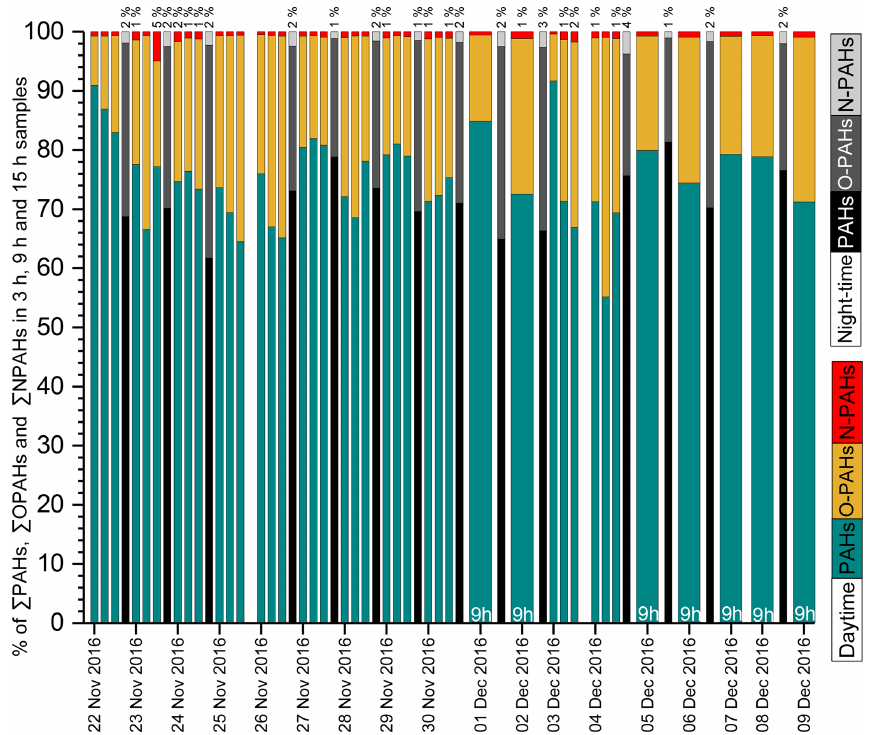
Figure 2. Time series of P PAHs, P OPAHs and P NPAHs in PM 2 . 5 samples during the daytime (3 and 9h) and night-time (15h). Percent- ages below 1% for NPAHs are omitted for clarity. Night-time data on 25 November 2016, 3 December 2016 and 7 December 2016 are not available due to a lack of